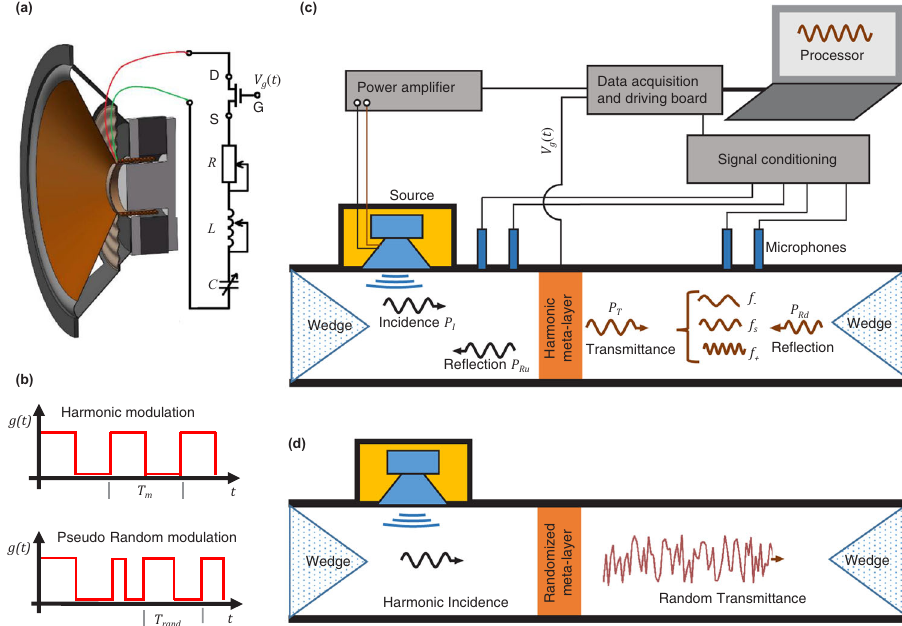
Fig. 1 Schematic of the proposed acoustic meta-layer (AML) and the conceptual diagram of frequency conversion. a AML formed by a shunted loudspeaker cascading a MOSFET unit (see Supplementary Note 1). G, D, and S represent gate, drain, and source ports of the MOSFET. The voltage supplied to G ( V g ) determines the effective resistance between D and S. b Schematic of the MOSFET state function, g t ð Þ = 1 for switch-on state, when the gating voltage V > 2 volt (see ( a )), and g t ð Þ = 0 for switch-off state. c Schematic of harmonic scattering in the waveguide and the measurement system. g Four waves are established in the waveguide, which are the incident ( p I ), re fl ected ( p Ru ), transmitted ( p T ), and the downstream re fl ected ( p Rd ) waves. The downstream transmitted wave contains components of f (cid:2) , f , and f þ . d Schematic of randomized AML with a random gating voltage, converting part of a s tonal input to white